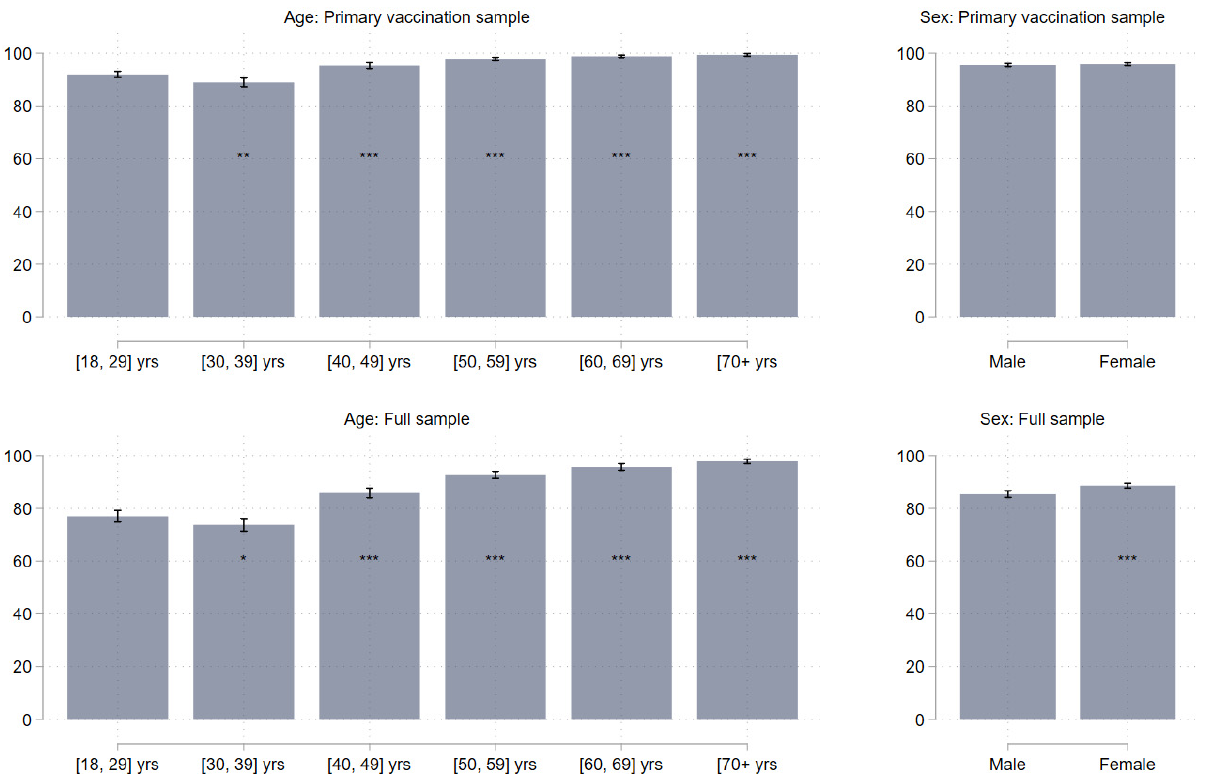
Figure 2. Booster vaccine willingness by age and sex. Note: Bars reflect the estimated willingness to take a booster dose. Whiskers denote 95% confidence intervals. * p < 0.05, ** p < 0.01, *** p < 0.001. Stars reflect whether there is a statistically significant difference between the reference category (age: 18–29 yrs; sex: male) and each of the other categories. Robust standard errors. Top panels reflect estimates from the primary vaccination sample (30,653), whereas the bottom panels reflect estimates from the full sample ( N = 31,721).